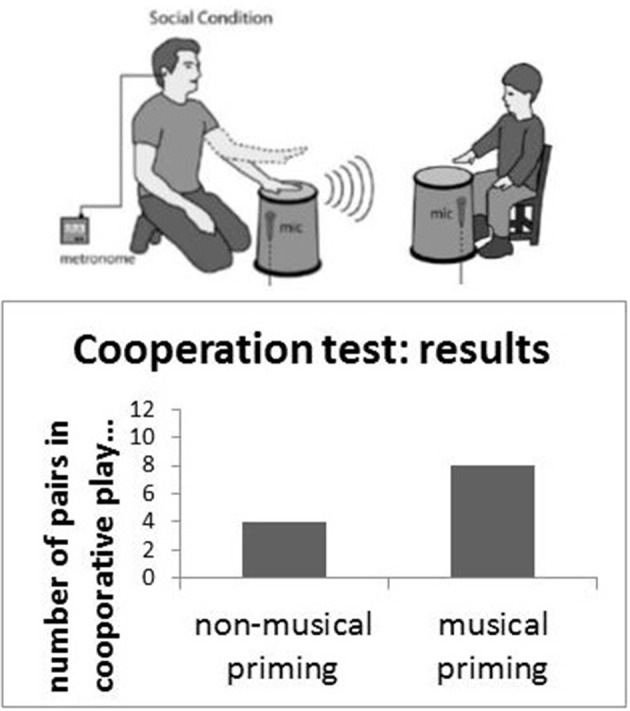
Joint social action and music making; musical priming leads to an increase in the number of cooperative players (Kirschner and Tomasello, 2009, 2010).